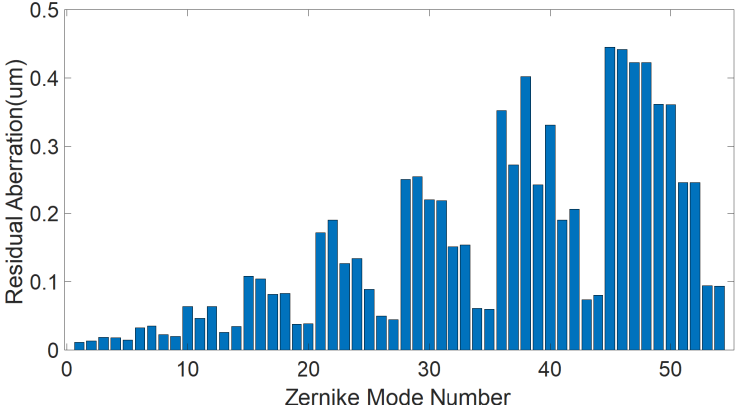
Figure 2. Fitting error of the top 54 Zernike modes with 145-unit DM .